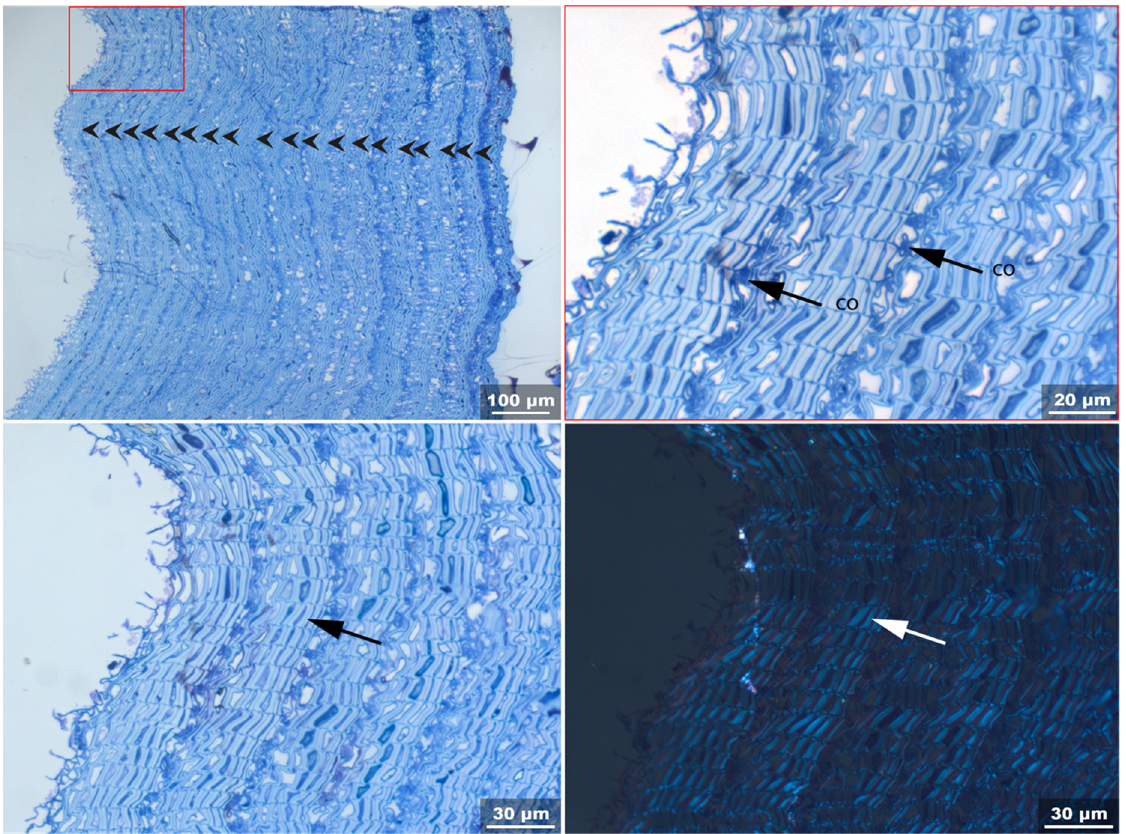
Figure 8. Reference sample. LM images of radial thin sections (left, outer surface; right, inner side) reveal thick-walled and thin-walled cell bands (arrowheads, top left). Tips of arrows indicate boundaries between thin-walled and thick-walled cell bands. Compressed thin-walled cells are marked with “co” (top right). Water affinity of thin-walled cell walls, compound middle lamella and tertiary walls can be appreciated from the intensity of blue staining. Thick-walled cell walls are hydrophobic (light blue) and show strong birefringence (bottom, left and right). Sample shows overall strong birefringence of thick-walled cells. While thin-walled cells usually have only very weak birefringence, the birefringence of thin-walled cell layer at boundary with thick-walled cells is just as strong as that of thick-walled cells.